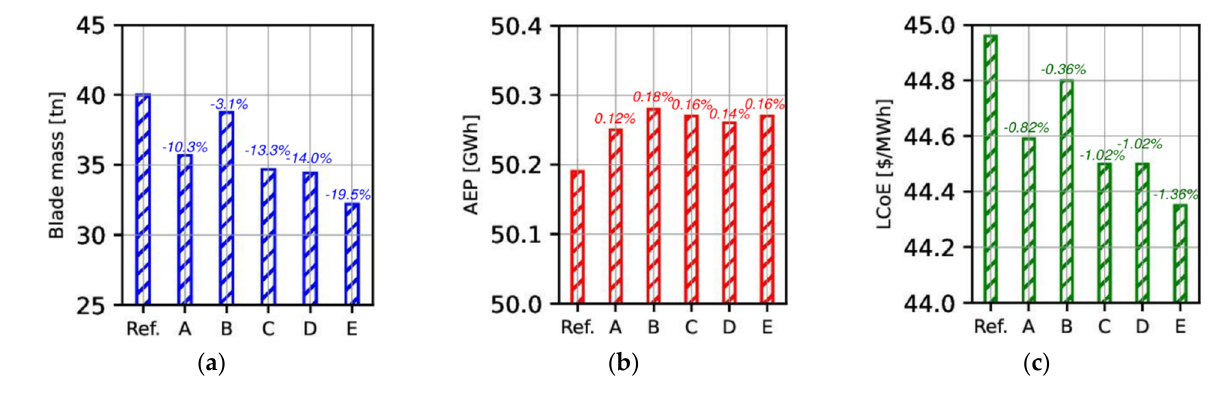
Figure 13. ( a ) Blade mass, ( b ) annual energy production and ( c ) levelized cost of energy of the different designs and relative percentage differences with respect to the reference configuration.